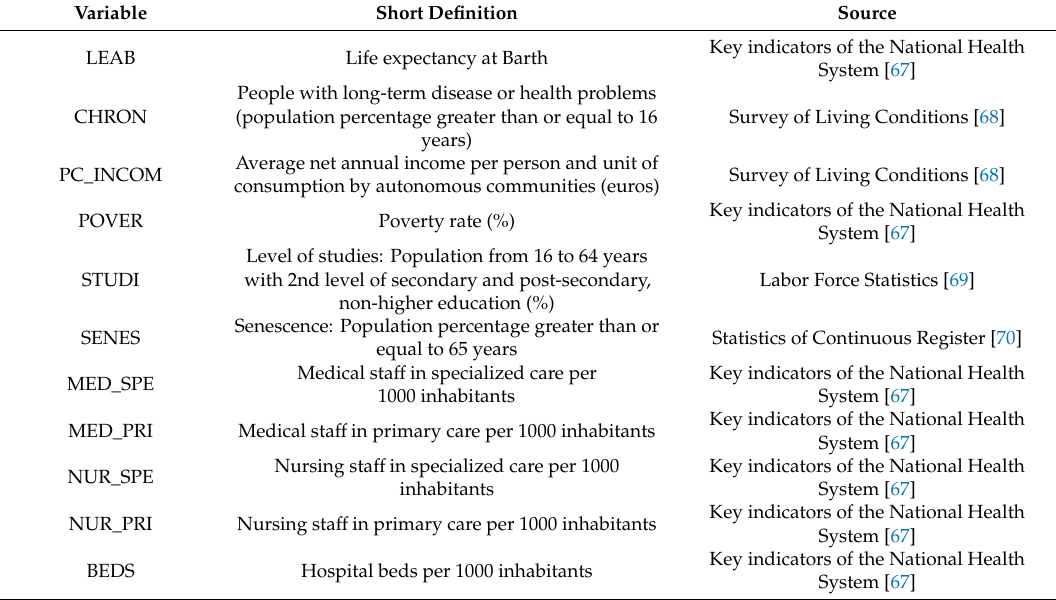
Table 1. Description of variables and their sources. Source : Own elaboration.